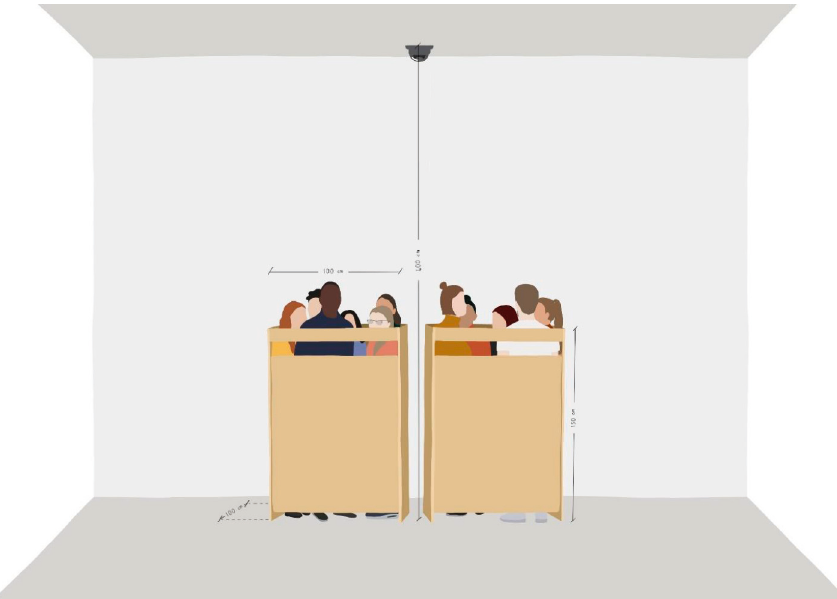
Figure 1: The figure shows the setup of the experiment, with the two boxes side by side and the camera above them. The figure also contains the dimensions used.